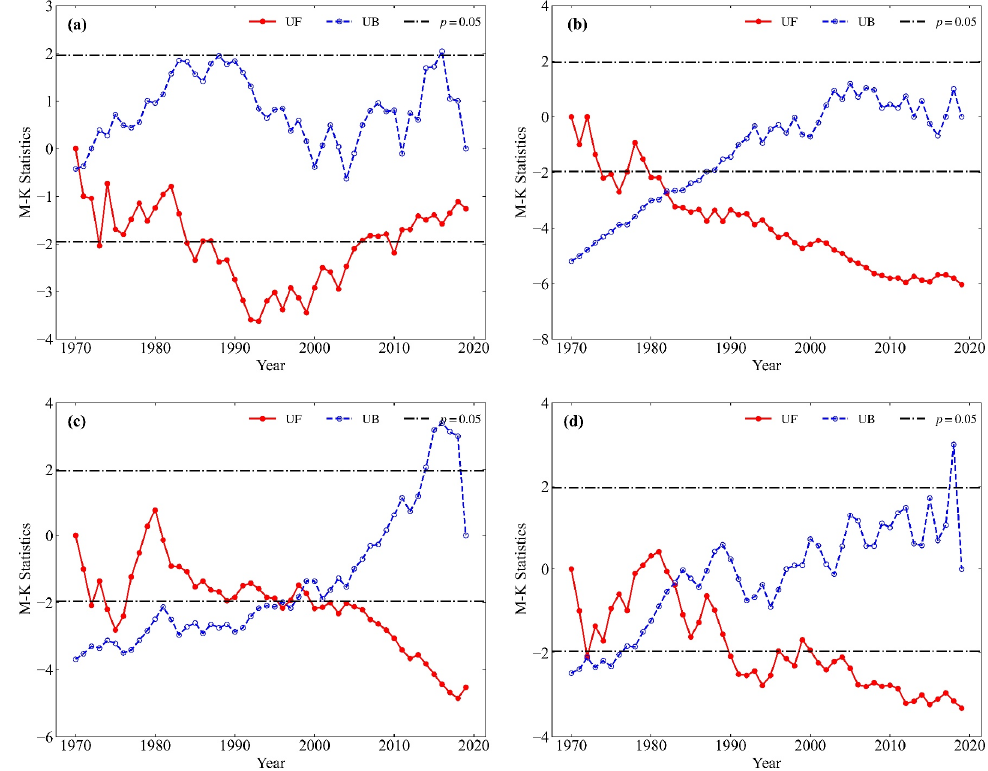
Figure 4. M–K mutation test of SD in ( a ) Spring, ( b ) Summer, ( c ) Autumn, and ( d ) Winter.